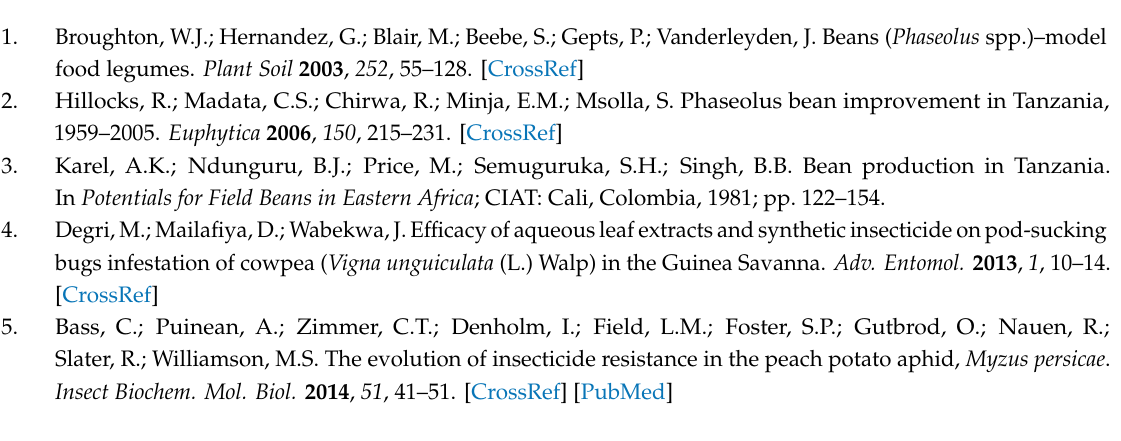
Figure S1: Parasitoids emerged from sentinel aphids, Figure S2: Sliding window analysis for LepF1 / C_ANTMRID and MLepF1 / LepR1 mini-barcodes, Table S1: Location of field sites, Table S2: Sequences from the NCBI database used to perform sliding window analysis for LepF1 / C_ANTMRID primers, Table S3: Sequences from the NCBI database used to perform sliding window analysis for MLepF1 / LepR1 primers, Table S4: Sequences from the NCBI database used to construct phylogenetic tree and Table S5: BLAST matches and accession numbers of parasitoids analyzed in this